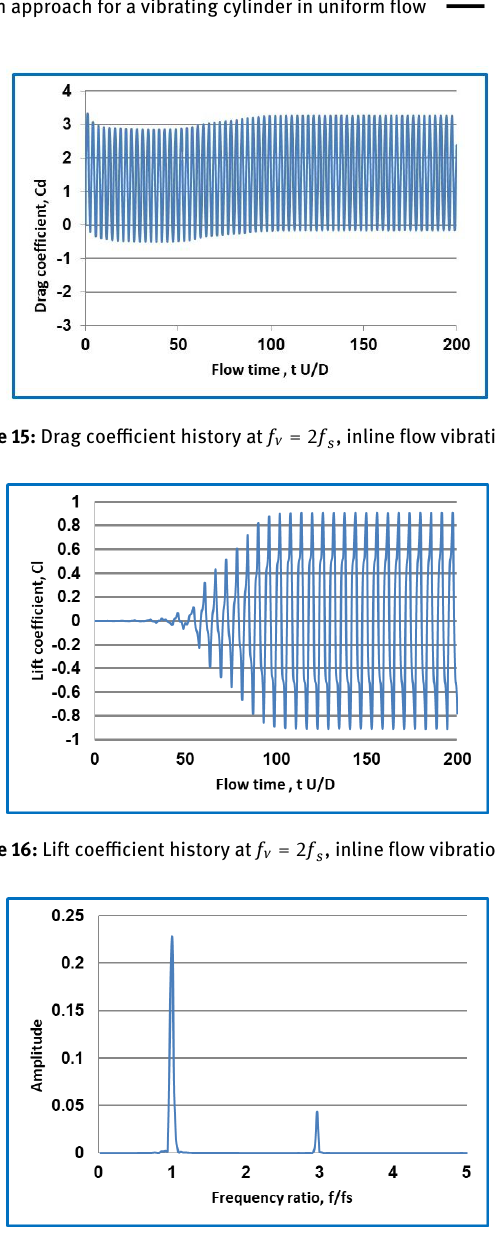
Figure 17: Power spectrum of lift coeflcient history at f v = 2 f s , inline flow vibration Table 2: The comparisons of the inline vibrating cylinder at f v = 2 f s